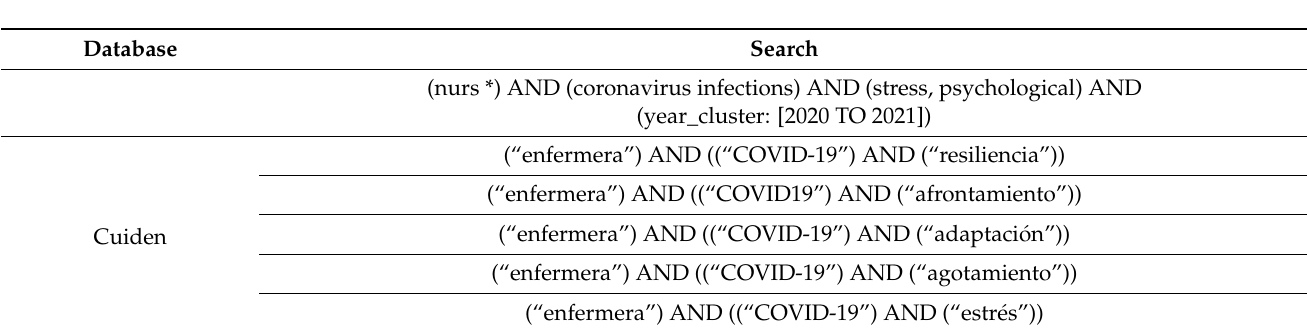
Table 1. Cont. Database Search (nurs *) AND (coronavirus infections) AND (stress, psychological) AND (year_cluster: [2020 TO 2021]) (“enfermera”) AND ((“COVID-19”) AND (“resiliencia”)) (“enfermera”) AND ((“COVID19”) AND (“afrontamiento”)) (“enfermera”) AND ((“COVID-19”) AND (“adaptaci ó n”)) Cuiden (“enfermera”) AND ((“COVID-19”) AND